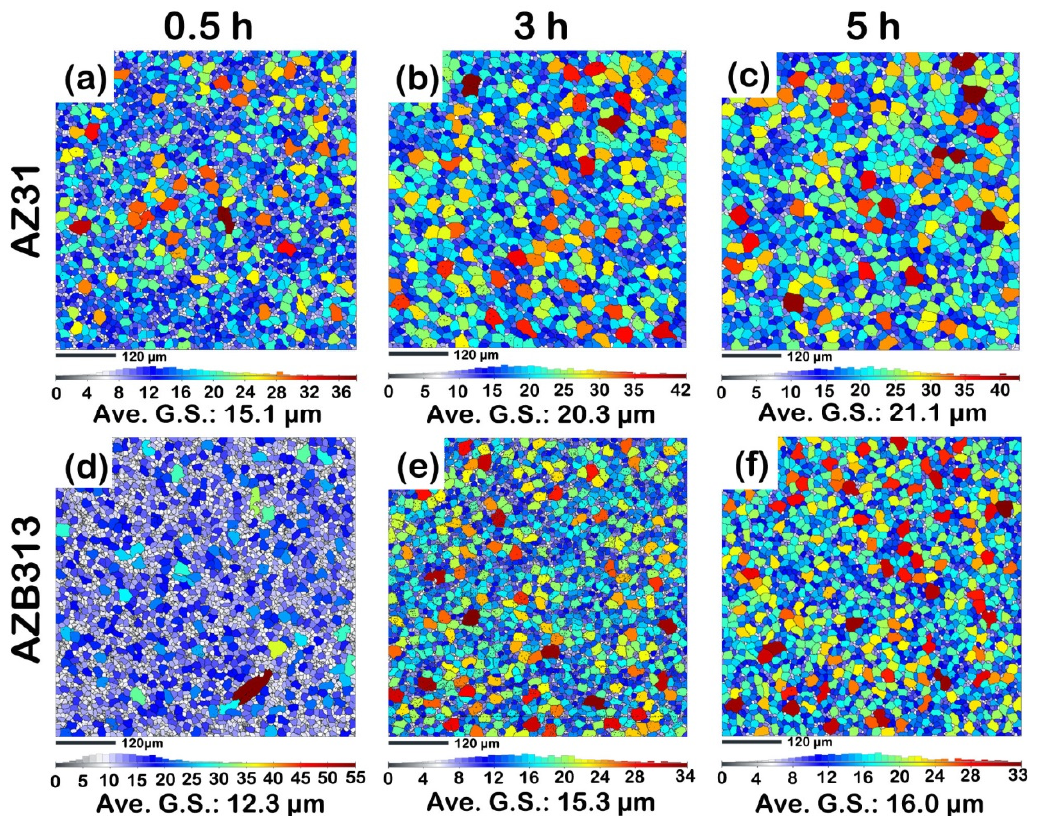
Figure 7. EBSD inverse pole figure maps showing grain size distribution during high-temperature annealing at 773 K for ( a , d ) 0.5 h; ( b , e ) 3 h; and ( c , f ) 5 h in as-extruded AZ31 and AZB313 alloys, respectively.